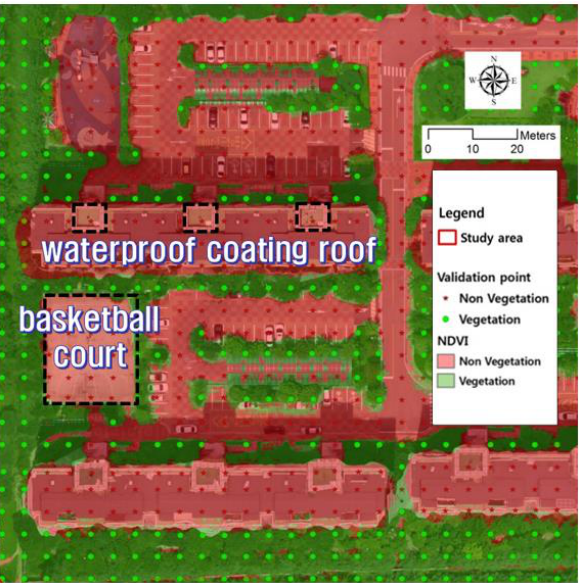
Figure 19. Vegetation map classified by applying NDVI and thermal infrared image around the basketball courts and the waterproof coating roofs.